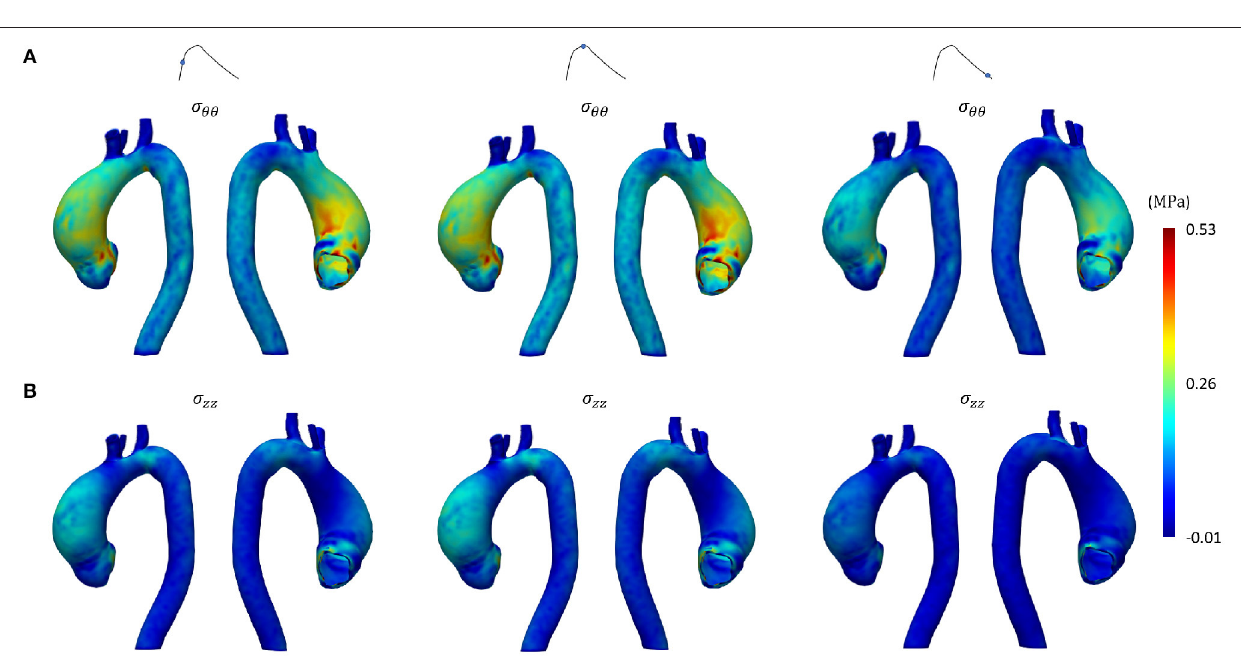
confirmed the trend from the LD simulation step. As expected, the circumferential stress range remains above the longitudinal stress one. In both simulations, the peak σ θθ stress values are confined within the inner curvature of the aTAA, as